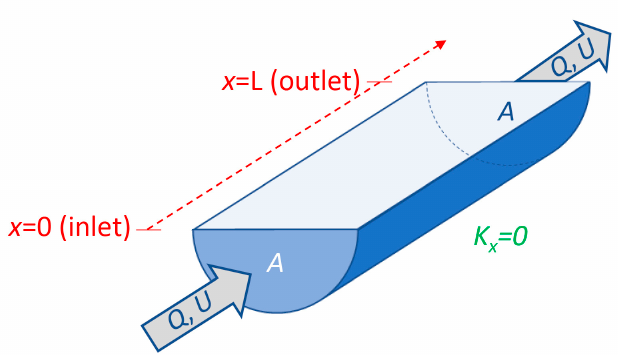
Figure A1. Depiction of plug flow (velocity U is uniform over the flow cross section; longitudinal diffusion K x is zero) in an idealized channel, for which cross-sectional area A is longitudinally uniform, channel length is L , and volumetric flow rate Q (and therefore U ) is constant and positive.